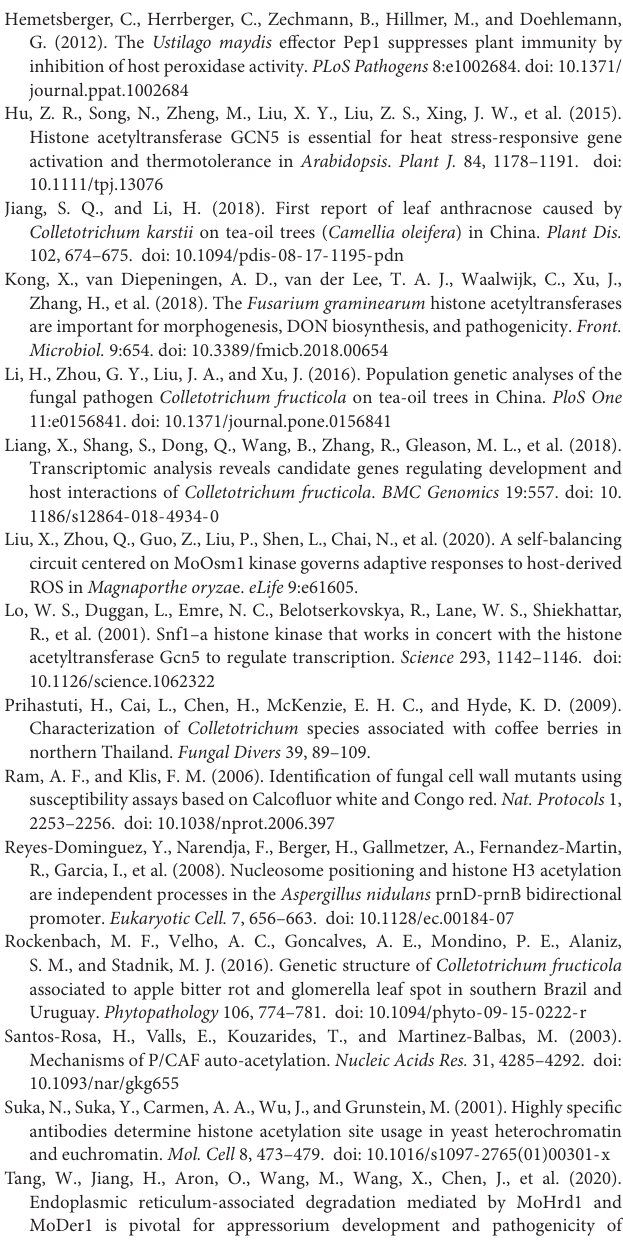
Supplementary Figure 1 | Generation of the CfGCN5 gene deletion mutant in C. fructicola . (A) Schematic illustration for deletion strategy of CfGCN5 gene. (B) Validation of the gene deletion mutant by PCR amplified with primers 1 (NBF/NBR) and primers 2 (BWF/HPHR). M: marker; + : positive control; -: negative control; #6: mutant. Supplementary Table 1 | Primers used in this